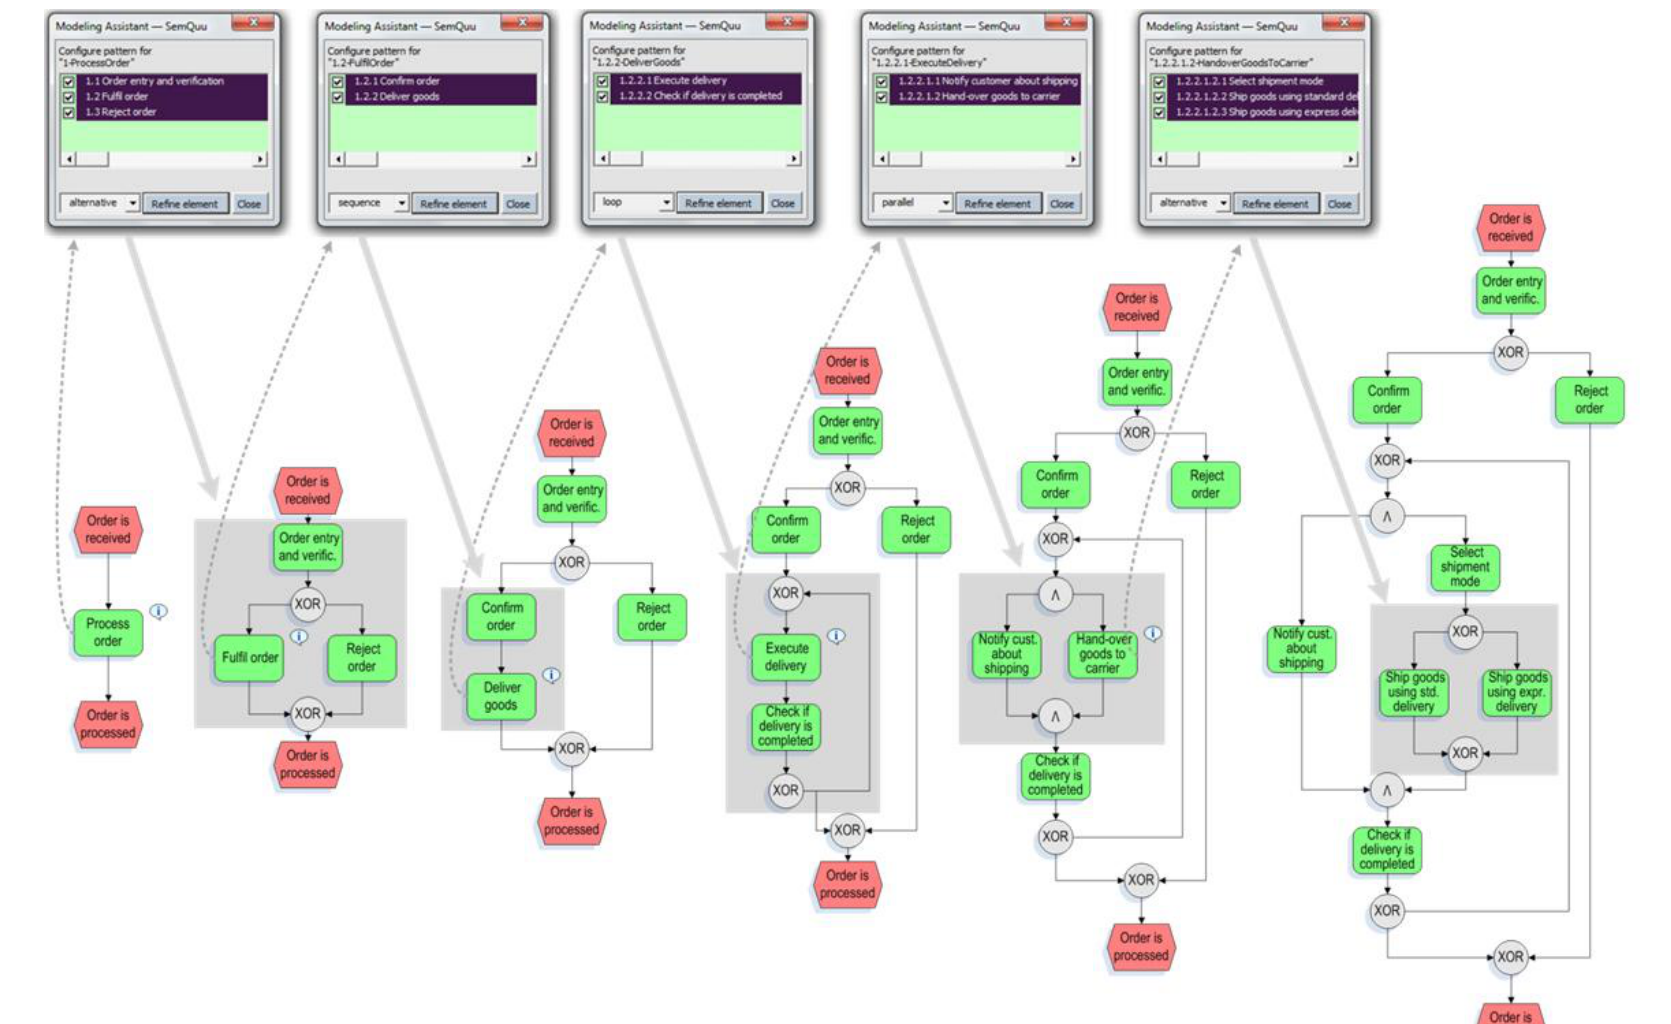
Figure 1. Extension of a modeling tool (Microsoft Visio) with a modeling assistant